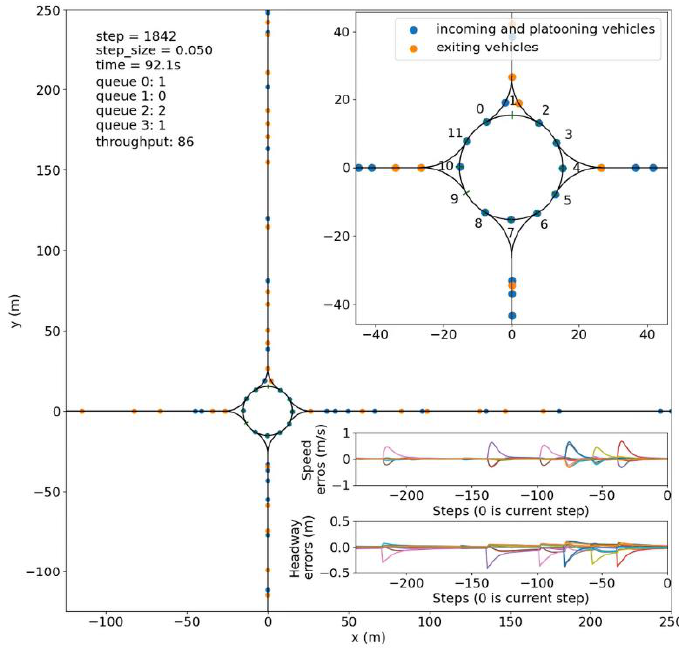
Figure 8. Simulation of the proposed roundabout control strategy.